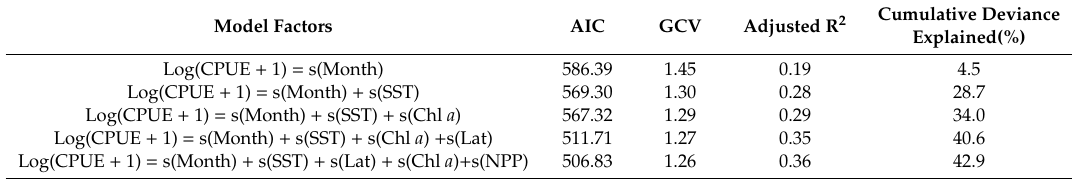
Table 2. Deviance analysis for general additive models (GAMs) fitted to the CPUE.